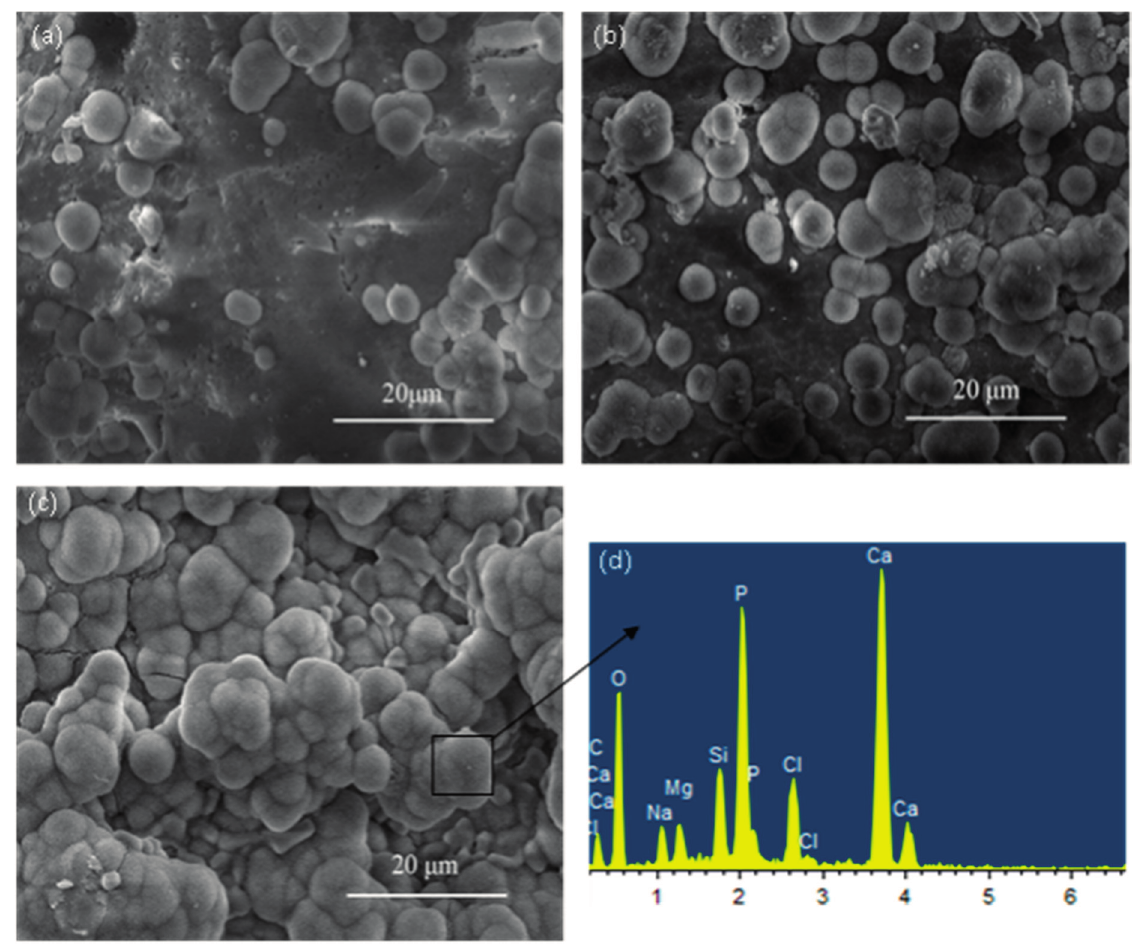
Figure 5. Bone-like apatite precipitated on the Di scaffolds for different periods of immersion ( a ) 7 days; ( b ) 14 days; ( c ) 21 days; and EDS spectra of ( d ) the globular bone-like apatite in ( c